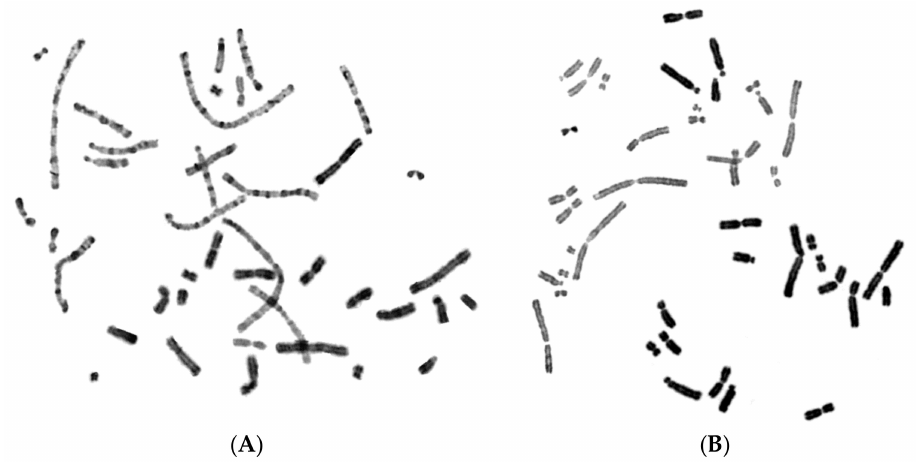
Figure 10. Early-G2 and late-G2 induced PCCs in multinucleated CHO cells. Based on the degree of completion of DNA replication in interphase nuclei in CHO multinucleated cells, the induced PCCs in interphase nuclei, upon entry of main nuclei into mitosis, can be classified as early-G2 with long lightly stained double chromatid chromosomes ( A ) or late-G2 with short lightly stained double chromatid chromosomes ( B ). The darkly stained condensed metaphase chromosomes belong to the main nuclei. Chromosome shattering in G2 phase PCCs was never